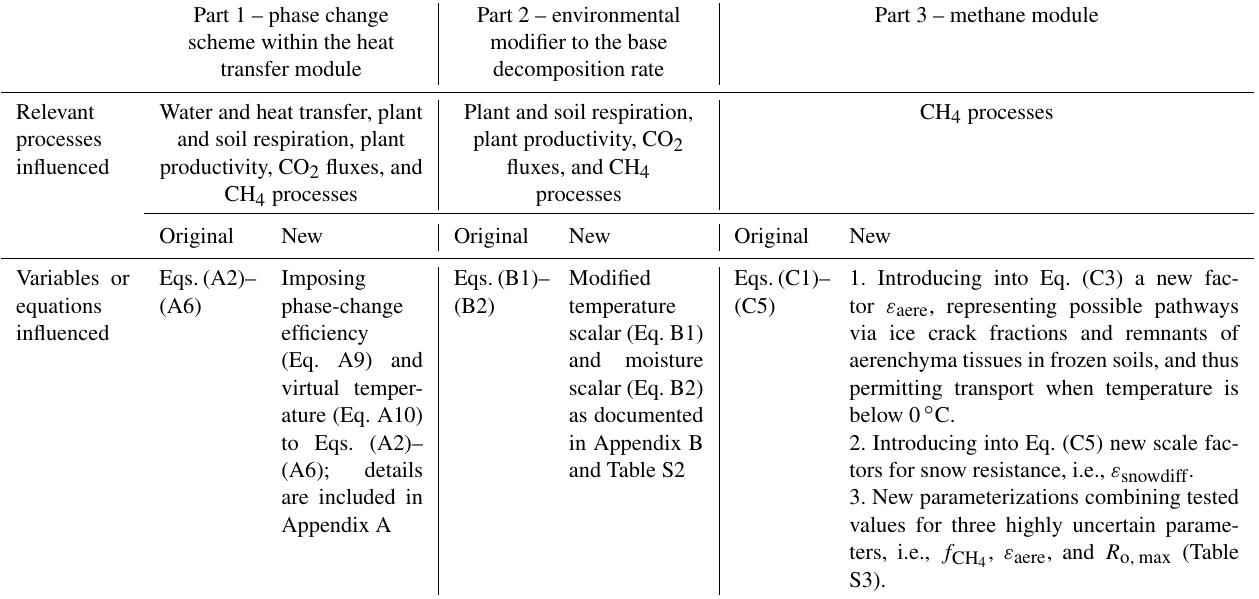
Table 1. Specific modifications made to